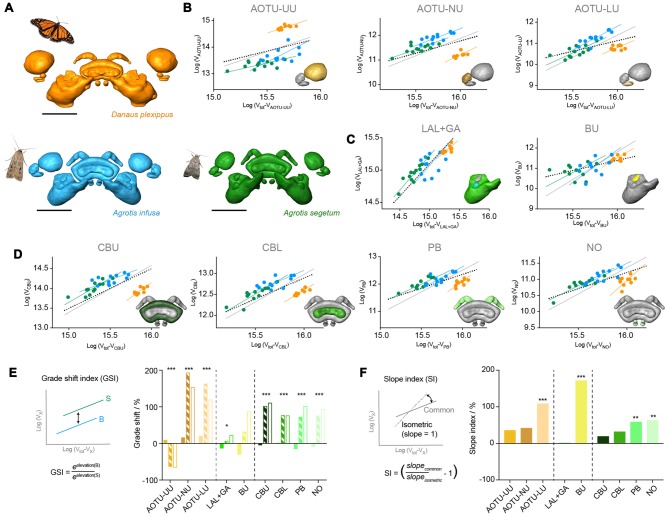
Results from standardized major axis regression analysis comparing the Bogong moth, the Turnip moth and the Monarch butterfly compass neuropils. (A) Surface rendering of neuropils in each species (shown in correct relative size), shown with image of each species. (B–D) Regression analysis data; colors matching neuropil color in (A). For each neuropil individual data-points are shown together with each species’ individual regression line, the best-fit common regression line (gray) and the isometric expectation (dotted). The inset depicts the respective neuropil for each graph highlighted in color. (B) Neuropils of the AOTU. (C) Neuropils of the LX. (D) Neuropils of the CX. (E) Analysis of GSI of all neuropils. Solid bars: Bogong moth—Turnip moth comparison (values > 0: Bogong moth bigger; values < 0: Bogong moth smaller); hatched bars: Bogong moth—Monarch butterfly comparison (values > 0: Bogong moth bigger; values < 0: Bogong moth smaller); open bars: Turnip moth—Monarch butterfly comparison (values > 0: Turnip moth bigger; values < 0: Turnip moth smaller). Left: schematic illustration and formula of how the GSI is calculated. Asterisks indicate significance level of GSI. (F) Analysis of SI for all neuropils. Values larger than zero indicate steeper than isometric scaling. Asterisks illustrate significance level of deviations from isometric scaling. Left: schematic illustration and formula of how the SI is calculated. Scale bars: 200 μm. Abbreviations: AOTU, anterior optic tubercle; UU, upper unit; LU, lower unit; NU, nodular unit; CBL, lower division of the central body; CBU, upper division of the central body; BU, bulb; LAL, lateral accessory lobe; GA, gall; PB protocerebral bridge; NO, noduli.